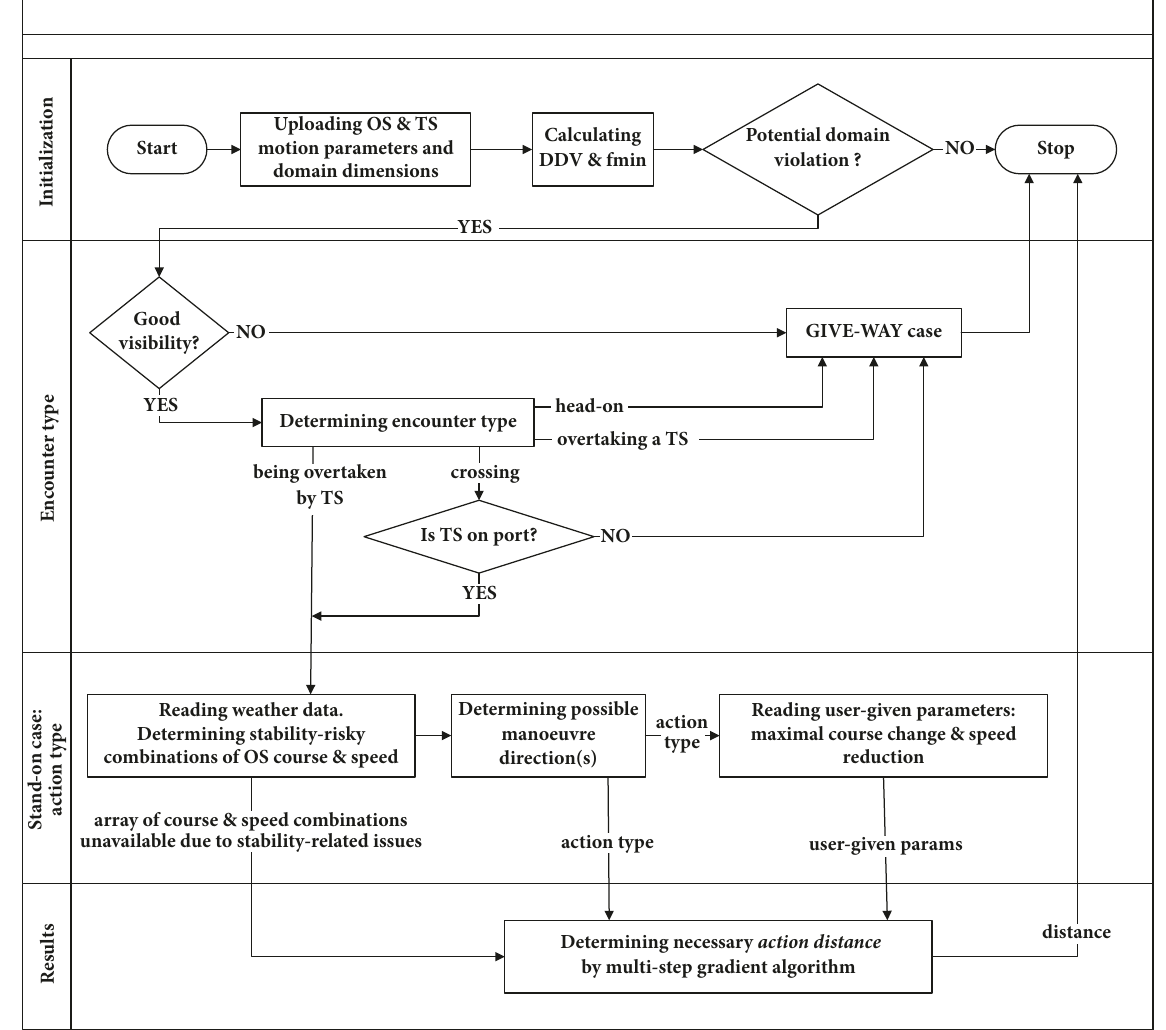
Figure 1: Determining distance necessary for avoiding domain violations in stand-on